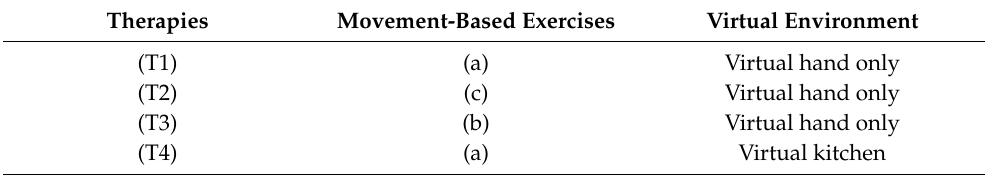
Table 3. Relationship between therapies, movement-based exercises and their virtual environ- ment.